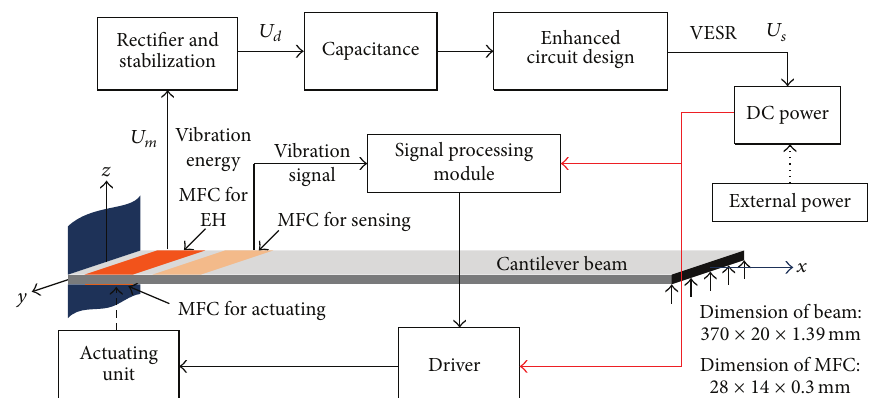
Figure 1: Block diagram of active vibration control with EH structure.